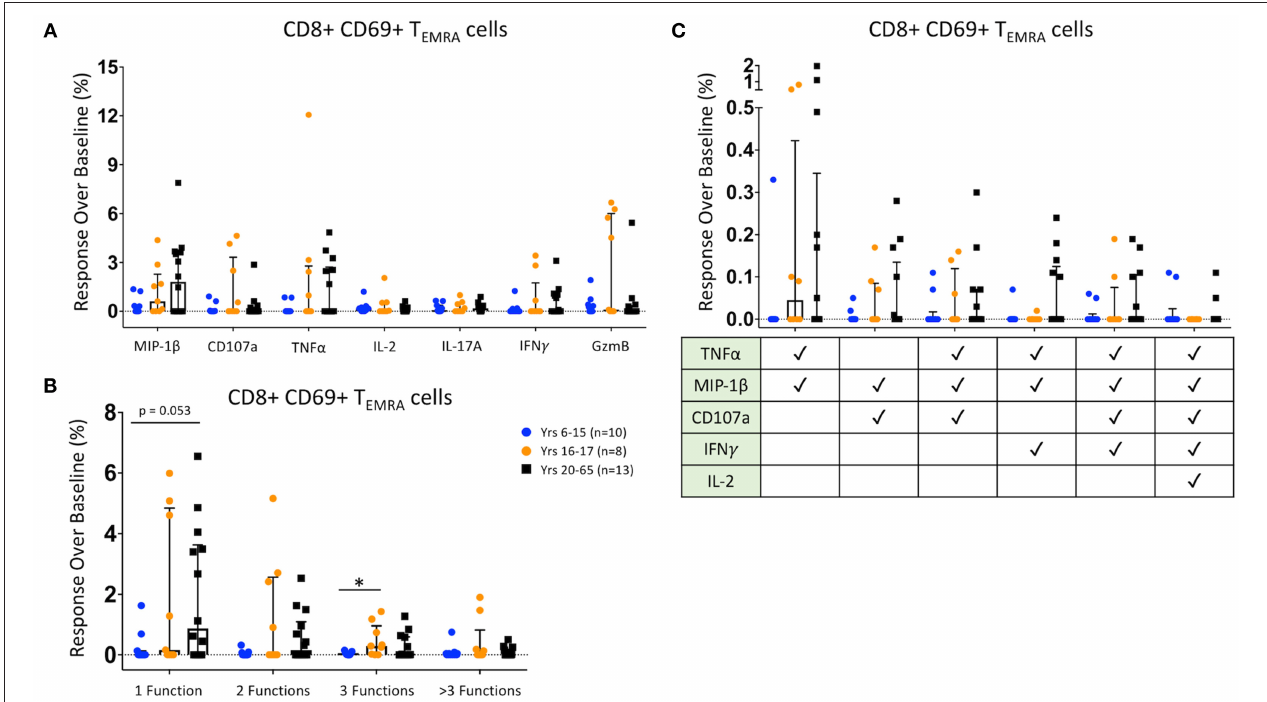
FIGURE 4 | CD8 + T Effector Memory RA Responses. Scatter plots showing (A) the responses over baseline percentages of CD8 + CD69 + T EMRA producing/expressing MIP1 β , CD107a, TNF α , IL-2, IL-17A, IFN γ , and Granzyme B (GzmB); (B) CD8 + CD69 + T EMRA observed mono-, bi-, tri-, and > 3-functional populations; and (C). specific CD8 + CD69 + T EMRA selected multifunctional responses following co-culture with HLA-E restricted S . Typhi infected antigen presenting targets. These MF populations were selected based on those shown in a previous S. Typhi challenge study to be associated with protection from developing disease (10, 11). Bars represent medians with whiskers indicating interquartile ranges. Results are shown for the following populations: 6–15 year-old pediatric ( n = 10), 16–17 year-old pediatric ( n = 8), and adult ( n = 13) participants. Scatter plot statistics were analyzed by unpaired t -test. (* p <